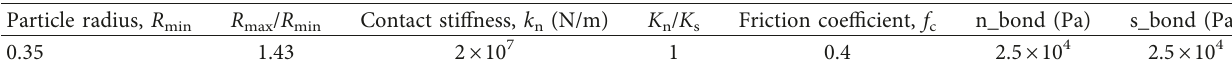
Figure 3: Osmotic calibration. Table 2: Microparameters of the